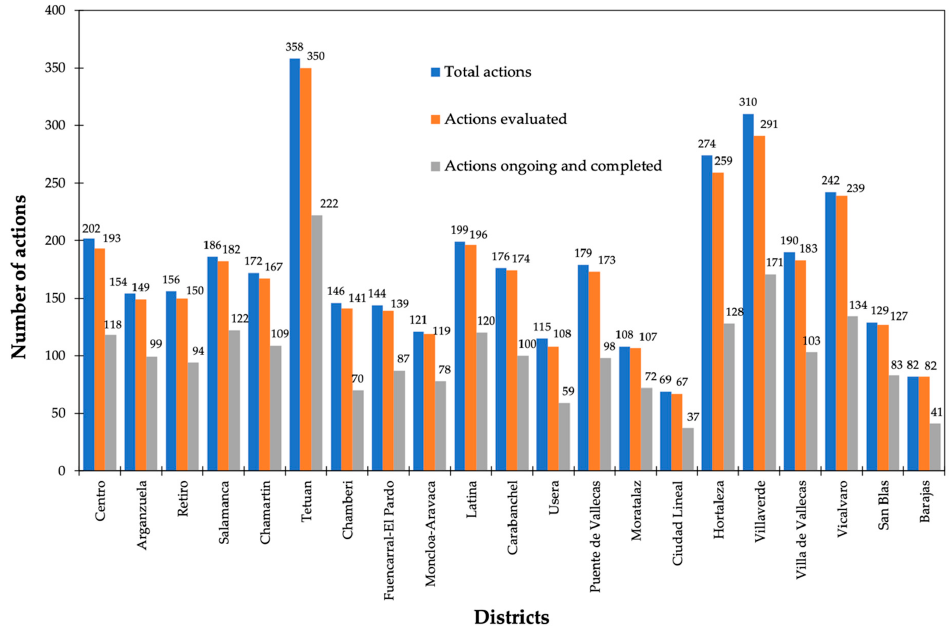
Figure 4. Actions evaluated, underway and completed in boroughs in Madrid [26].